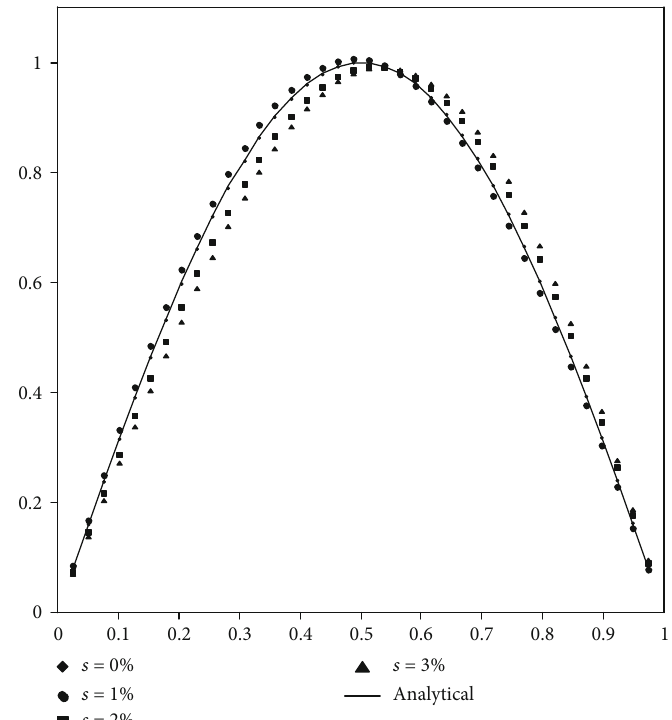
= 0 : 1 with various levels of noise added into the input data f